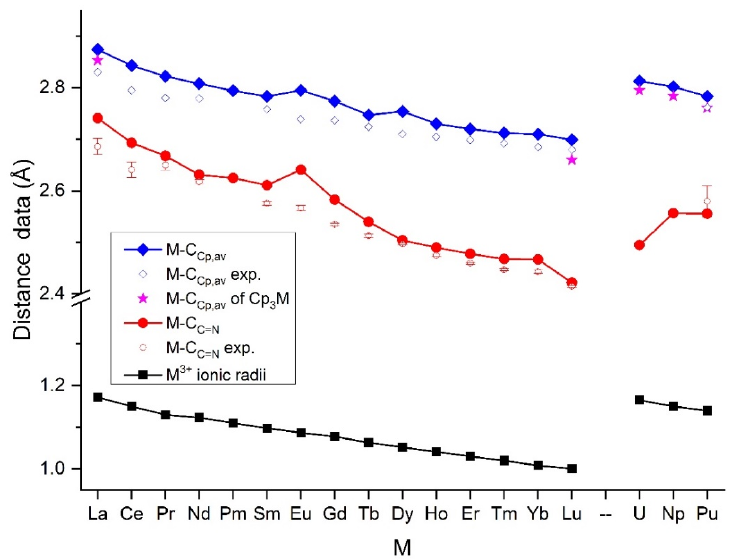
Figure 2. The metal–ligand M-C C ≡ N and average M-C Cp distances (Å) of (Cp) 3 M(C ≡ NCy) and M(Cp) 3 complexes as well as the six-coordinate effective M 3+ ionic radii [40]. The non-averaged experimental data are extended with the standard deviation bars.